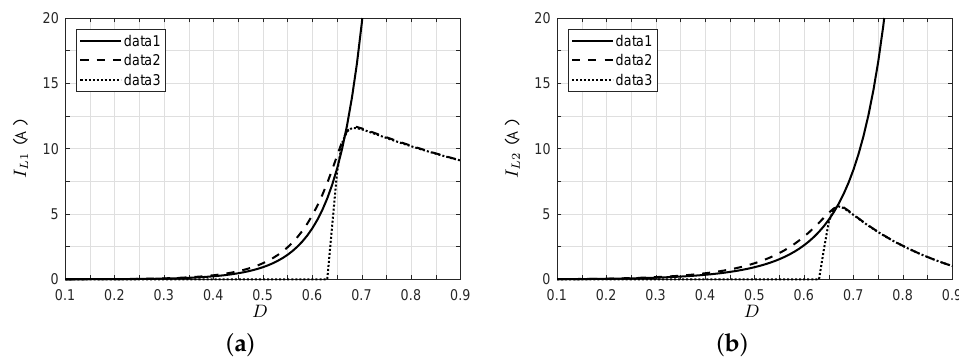
Figure 10. Inductor currents in the steady state of the proposed converter (data 1: voltage converter appl; data 2: PV appl, resistive load; data 3: PV appl, clamped voltage). ( a ) Inductor L 1 . ( b ) Inductor L 2 .